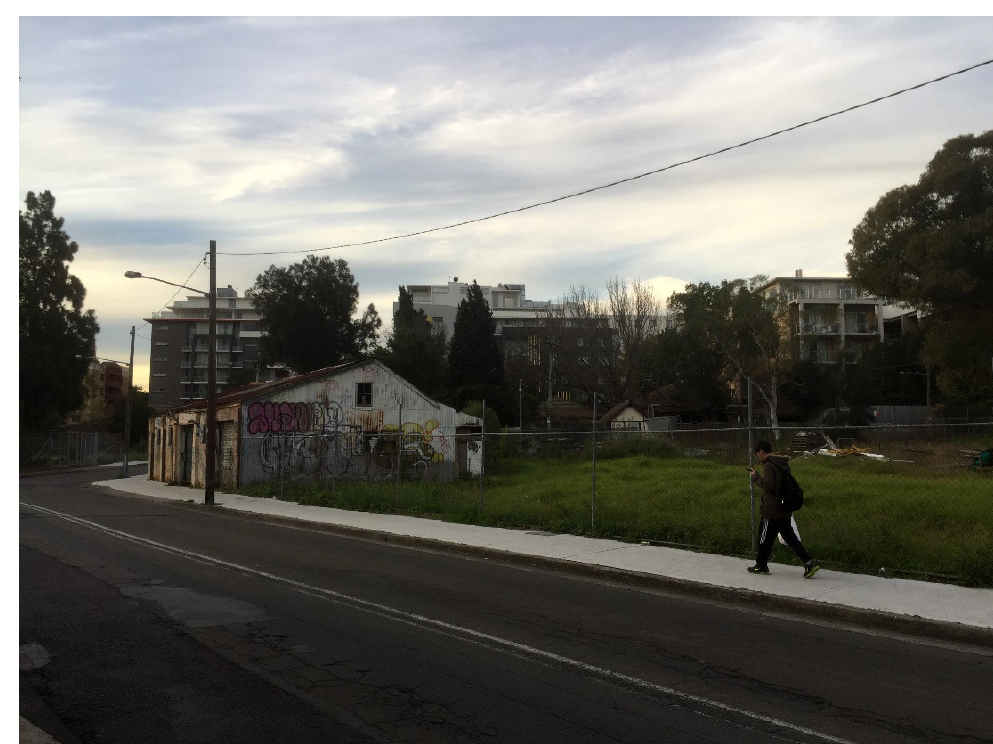
Figure 4. Vacant lot in Upper Strathfield, facing northwest along Cooper Street.